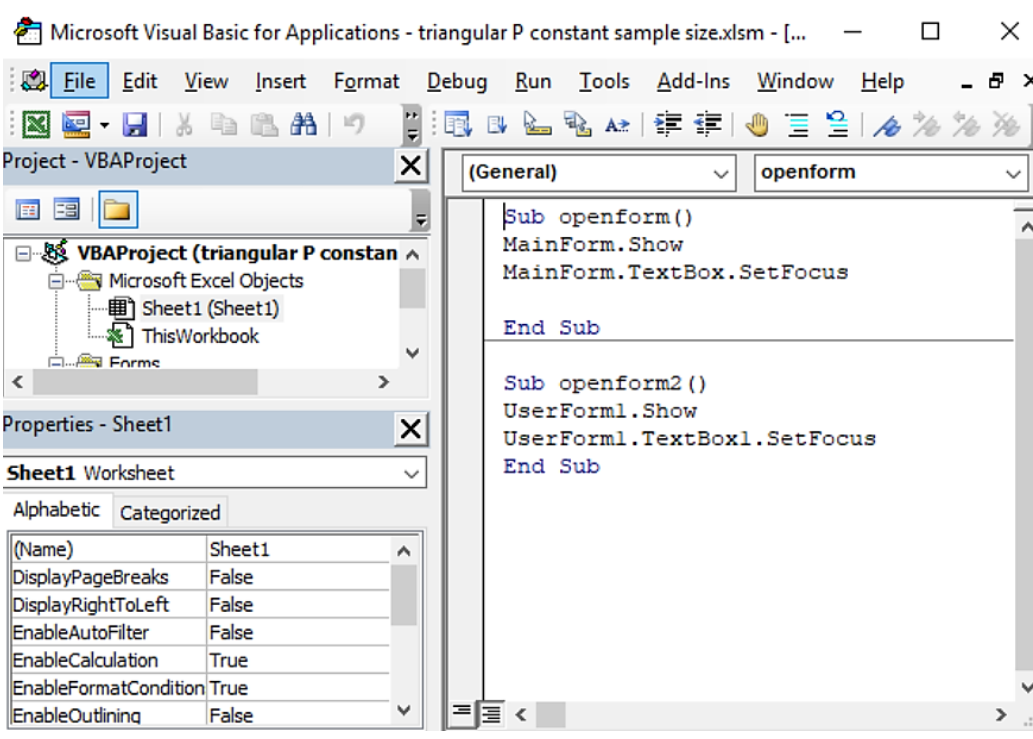
Figure 3. Visual Basic Coding for Input Box in the Excel